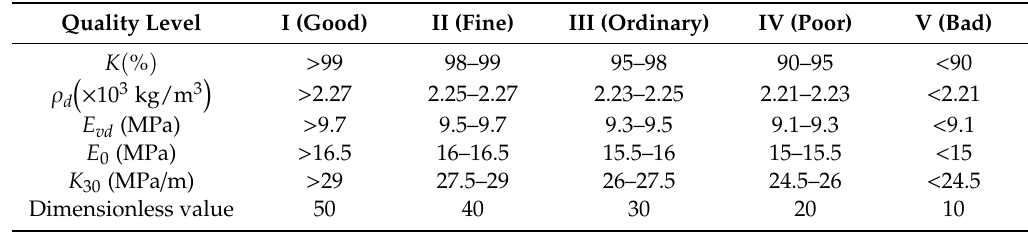
Table 3. Quality-level classification standard for the physical and mechanical indices in earth-rock dam